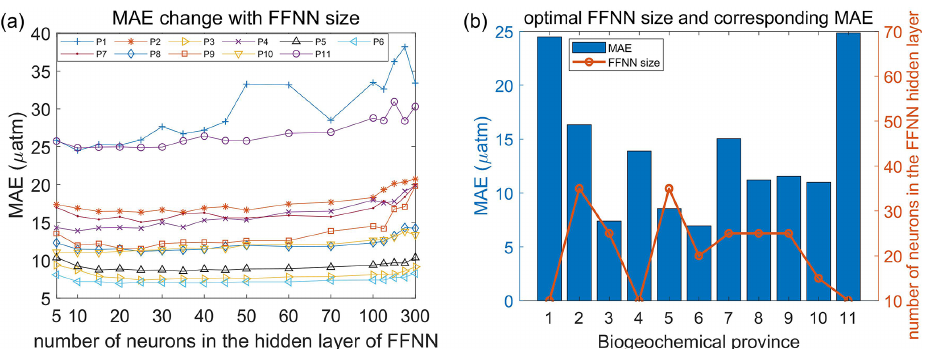
Figure 5. MAE of different FFNN size in each biogeochemical province. (a) MAE between predicted p CO 2 and SOCAT observations was calculated using the same samples and FFNN with a different number of neurons. (b) The optimal FFNN size refers to the number of neurons when MAE is